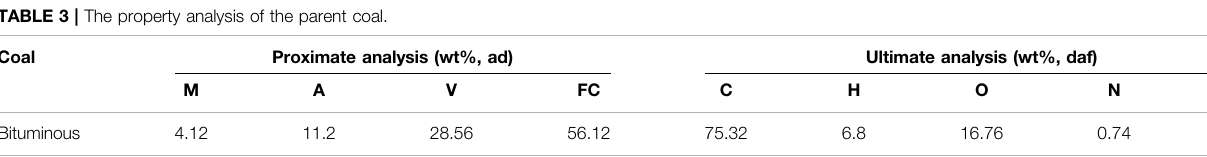
TABLE 3 | The property analysis of the parent